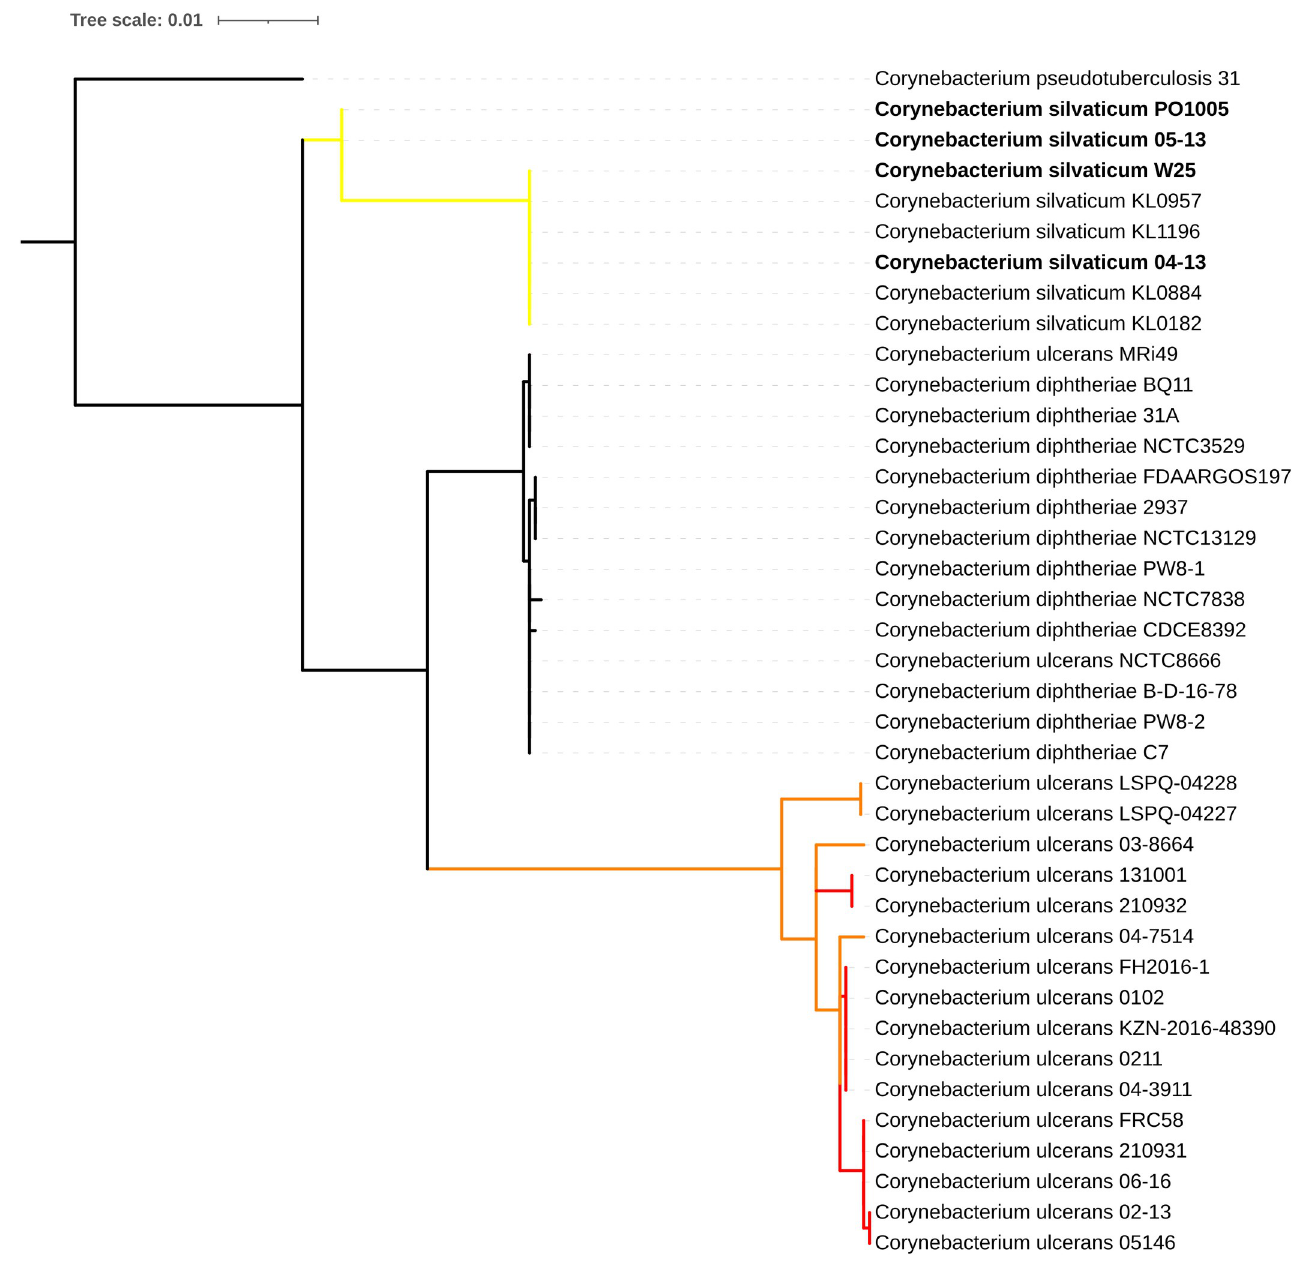
Fig 2. Phylogenetic tree of the tox gene from Corynebacterium species. The phylogeny was inferred using the Maximum Likelihood method and the Tamura- Nei (T92 + G) model implemented in Mega v10.1.6. The strains PO100/5, 04–13, W25 and 05–13 cluster with Corynebacterium silvaticum . Clade colors represent rpoB clades of C . silvaticum (yellow) and C . ulcerans (red and orange).